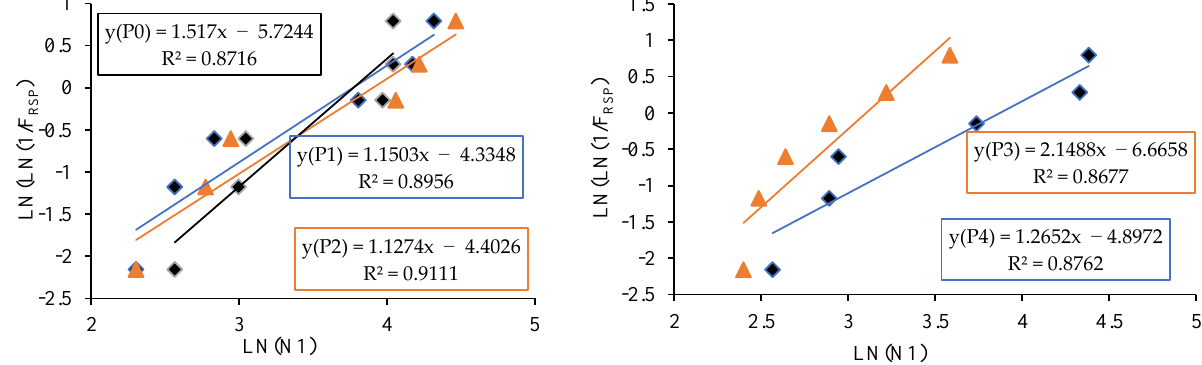
Figure 18. Weibull distribution for P0, P1, P2, P3 and P4 mixes at initial crack on 7 Figure 20. Weibull distribution for P0, P1, P2, P3 and P4 mixes at initial crack on 7 days.